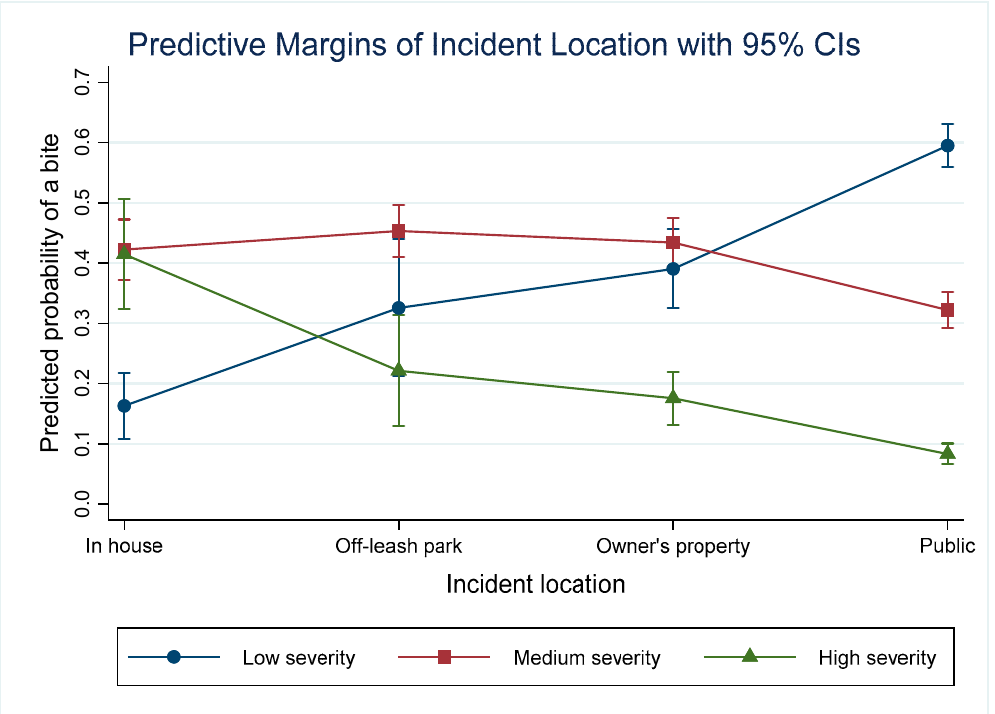
Figure 2. Predictive margins for the different severity incidents depending on the incident location and controlling for other variables in the model.